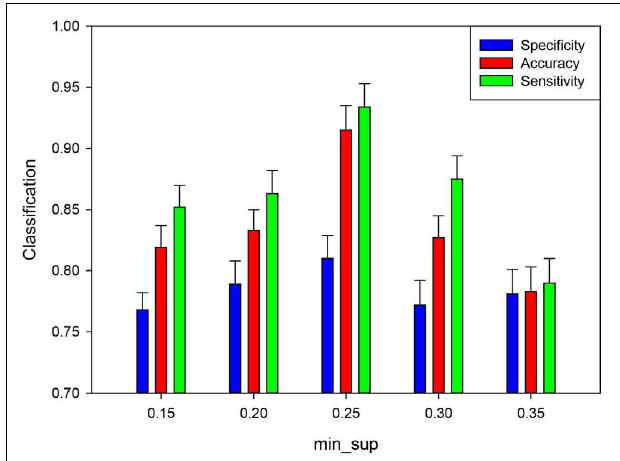
FIGURE 10 | Effect of the minimum support degree ( minsup ) of unFEPG method on the classification performance. Green denotes the sensitivity in different feature numbers. Blue denotes the specificity in different feature numbers. Red denotes the accuracy in different feature numbers.